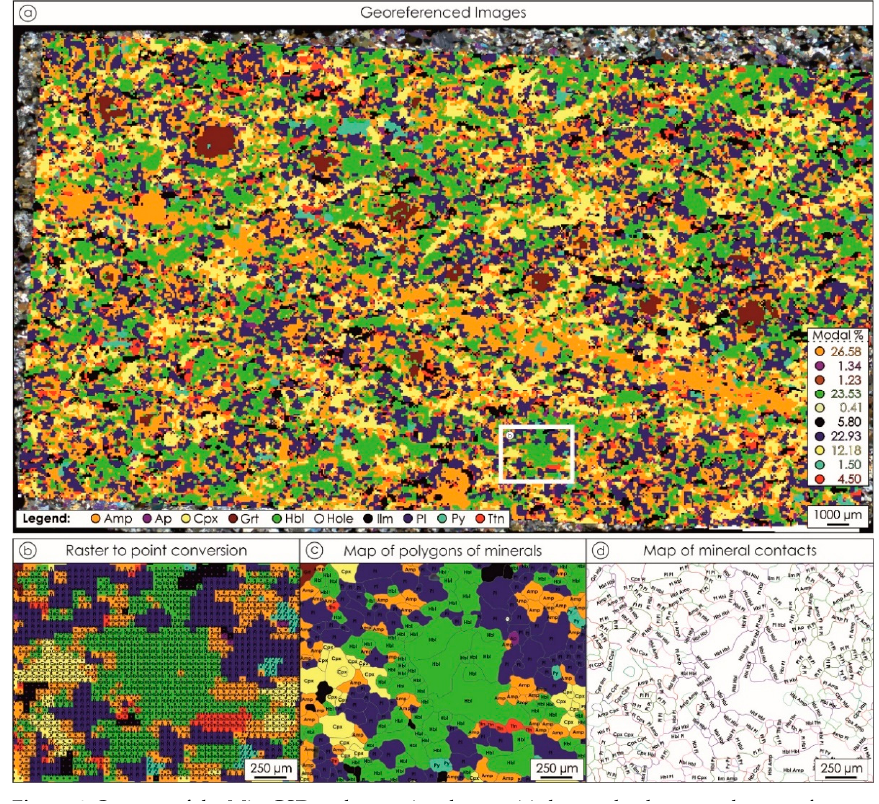
Figure 6. Outputs of the Min-GSD tool operational steps: ( a ) the overlap between the georefer- enced map of minerals obtained by Q-XRMA on the thin section image. The white square repre- sents figure b; ( b ) results of the raster to point conversion of the mineral classification map; ( c ) map of the digitized grains quantified per mineral phase; ( d ) grain boundaries map showing con- tacts of mineral couples. Mineral abbreviations from [56].